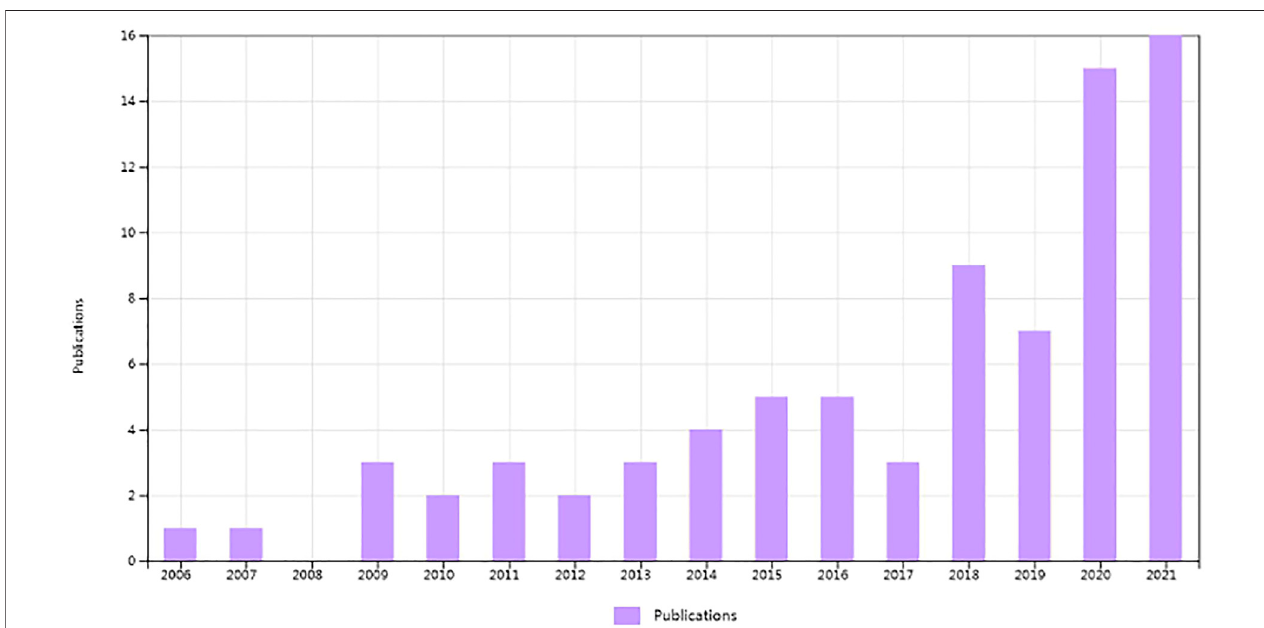
FIGURE 1 | HPM applied GWR publication